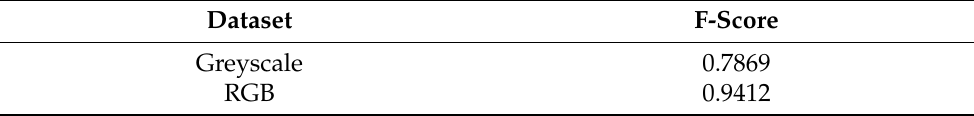
Table 3. The influence of color information (Image Manipulation